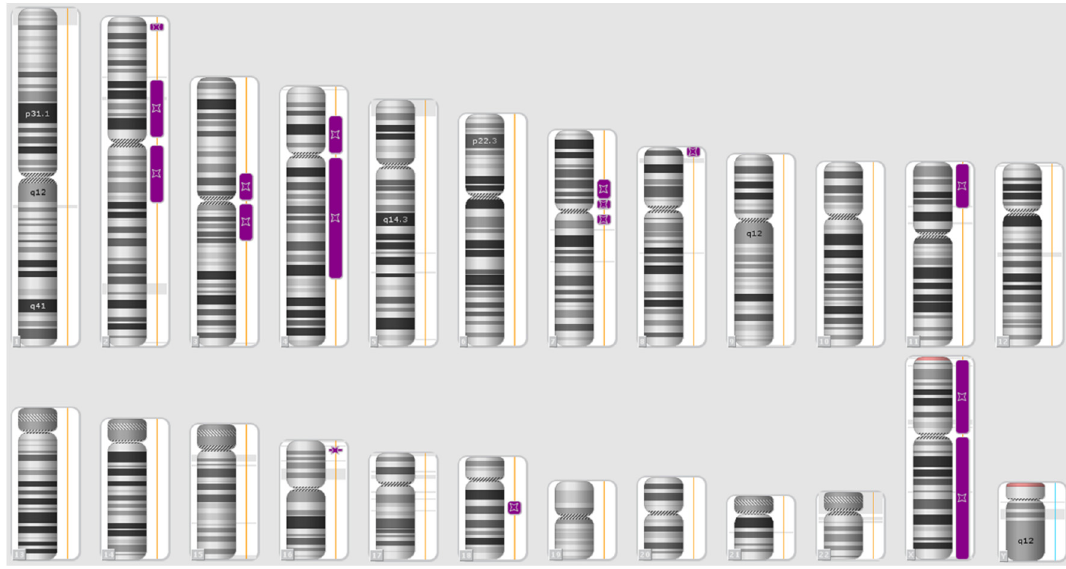
Figure 1. Karyoview of the patient. Regions of homozygosity (ROHs) identified in the proband genome are indicated by purple bars. Table 1. List of regions of homozygosity (ROHs) identified in the proband genome according to the International System for Human Cytogenetic Nomenclature (ISCN 2016). Size and number of genes included in each ROH are indicated. All genomic coordinates were based on the GRCh37/hg19 build of the Human Genome.